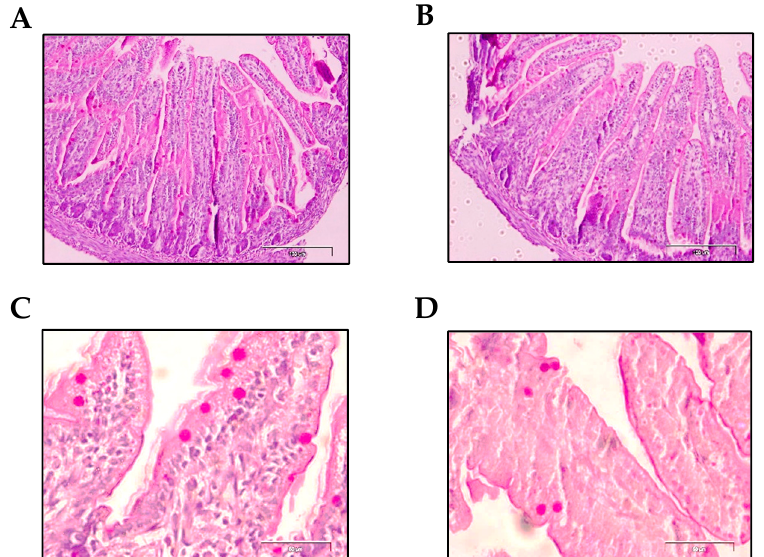
Figure 6. Representative images of histological sections of the jejunum with PAS staining. Term group ( A and C ) and preterm group ( B and D ). Goblet cells with densely stained granules can be observed along the length of the villi ( C and D ). Scale bar = 100 μ m for 100X and 50 μ m for 400X. Magnification = 100X ( A and B ) and 400 X ( C and D ).